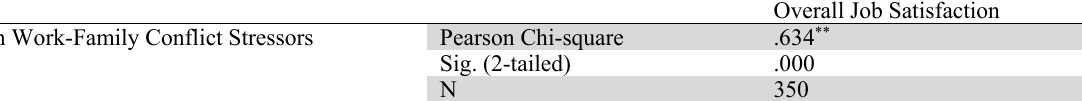
Chi-square tests for Work-Family Conflict Stressor